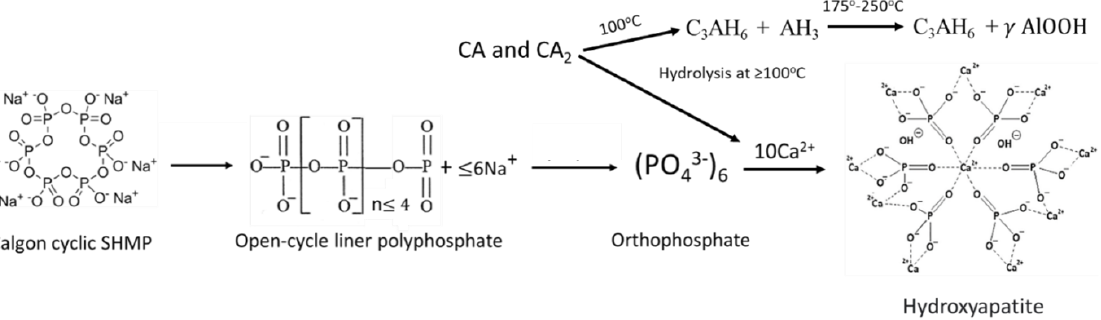
Figure 7. Illustration of cement-forming acid – base and hydration reactions in neat CaP cement.